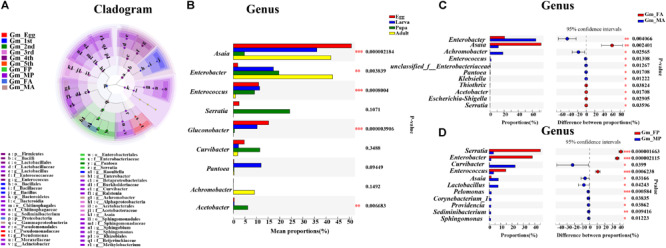
Significant difference analysis of the bacterial community in the development of G. molesta. (A) LEfSe analysis showing significant differences of microbial species at the level of phylum, class, order, family, and genus from inside to outside. Different color nodes represent microbiota that is significantly enriched at the corresponding life stages. Small yellow nodes indicate microbiota that has no significant difference at different life stages. (B) Significant differences of microbial composition in eggs, larvae, pupae, and adults (one-way ANOVA followed by Scheffe test, P ≤ 0.05). (C) Comparison of microbial species between FA and MA by independent t test. (D) Comparison of microbial species between FP and MP by independent t test. Abbreviations: Gm = Grapholita molesta, 1st = first instar, 2nd = second instar, 3rd = third instar, 4th = fourth instar, 5th = fifth instar, FP = female pupa, MP = male pupa, FA = female adult, and MA = male adult.